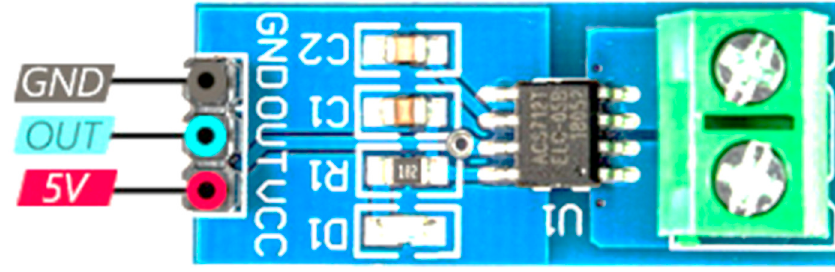
Figure 2. ACS712 current sensor module.